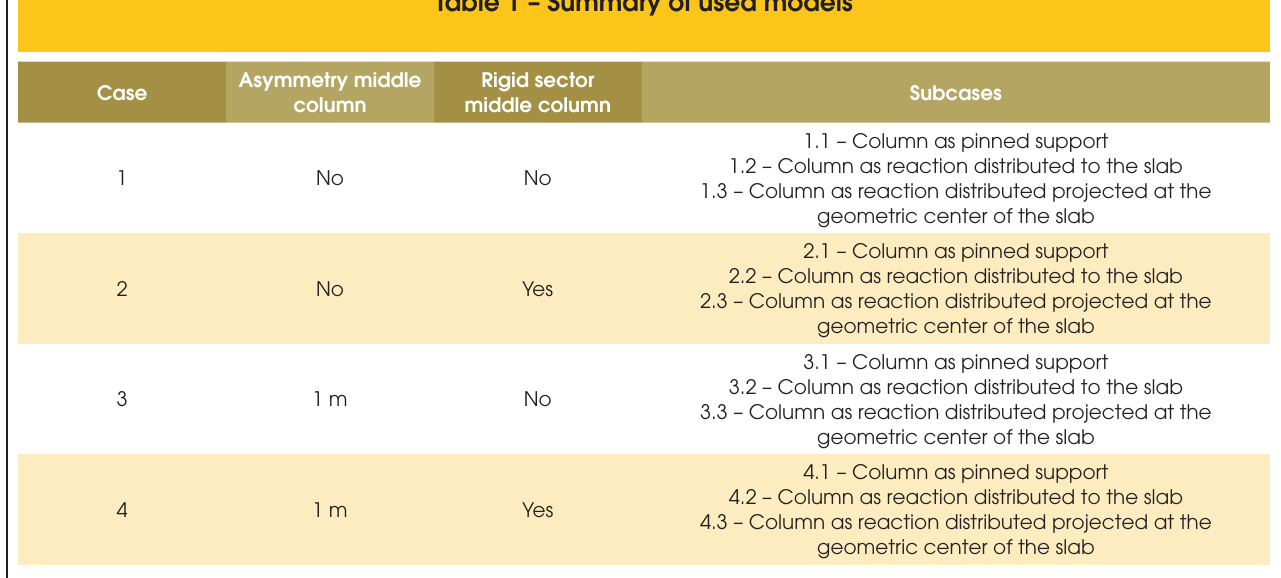
Table 1 – Summary of used